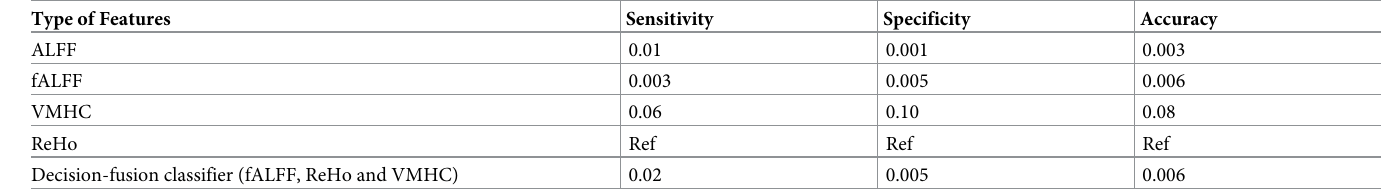
Table 5. P-values for test of significance of the outcomes of the classifiers based on single-feature-type classifiers and decision-level classifier. Statistical comparison is made with respect to the ReHo-based classifier.